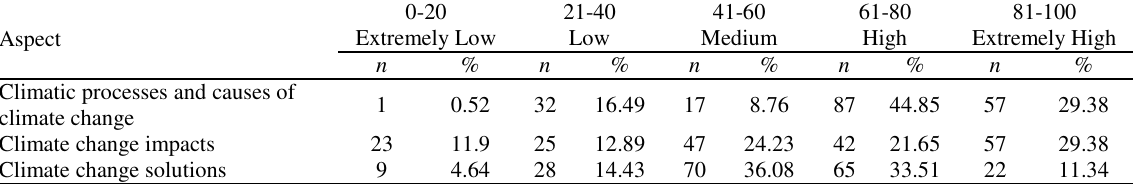
Table 3 Descriptive analysis of the score frequencies for the three dependent variables of climate change science